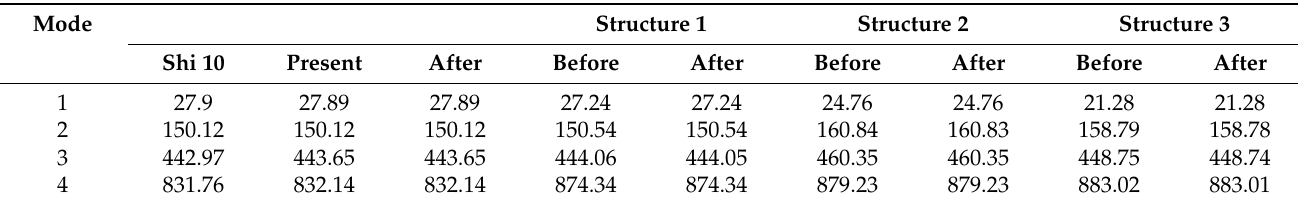
Table 2. ACLD cantilever beam natural